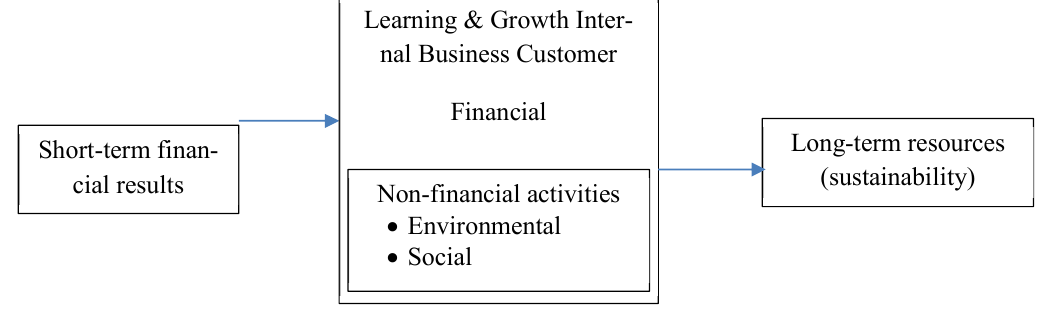
Fig. 2. SBSC, short-term financial results and long-term resources